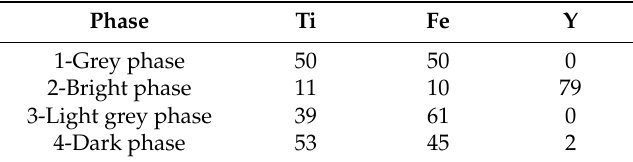
Table 2. Measured atomic abundances of the various phases presents in the TiFe alloy + 4 wt.% Y. All values are in at.%. The error on each value is ± 1%.